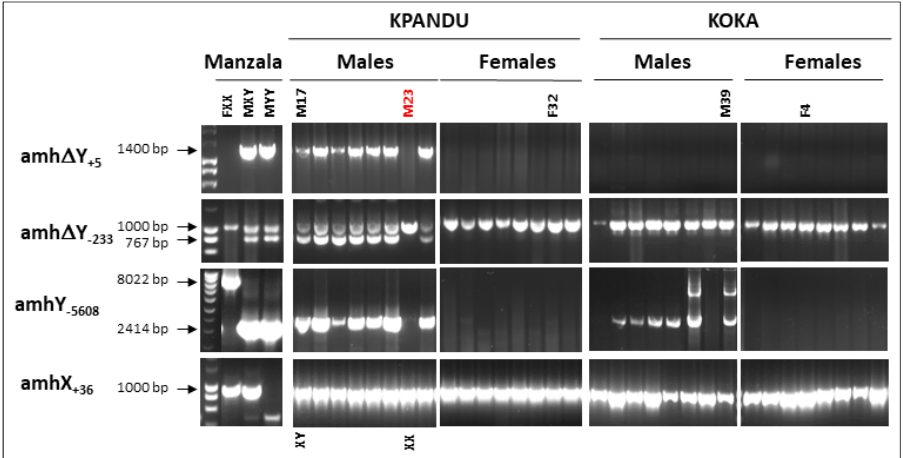
Figure 2. Amh genotyping of the Kpandu and Koka breeders used in ddRAD and a subset of individuals used in the whole-genome sequencing (WGS) pools. The complete genotyping of all individuals is shown in Figures S1 and